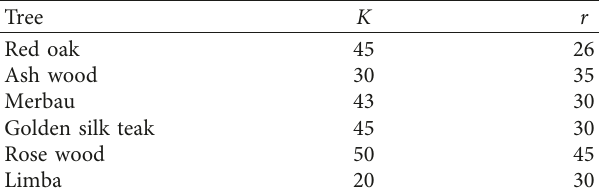
Figure 15: Vessel peripheral region extraction with best r and k for 6 species. (a) Red oak. (b) Ash wood. (c) Merbau. (d) Golden silk teak. (e) Rose wood. (f) Limba. Table 5: Best values for parameters r and k